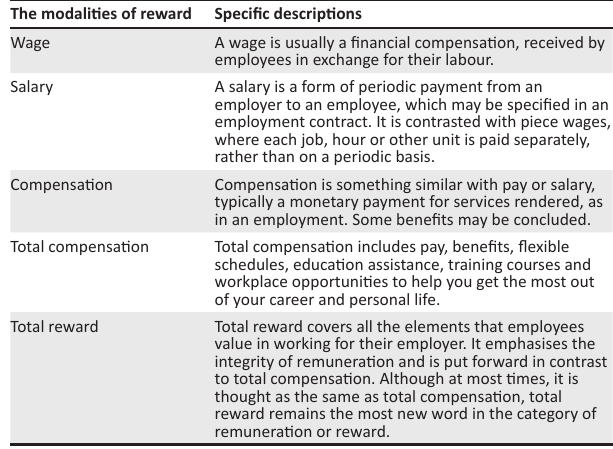
TABLE 1: Phases of